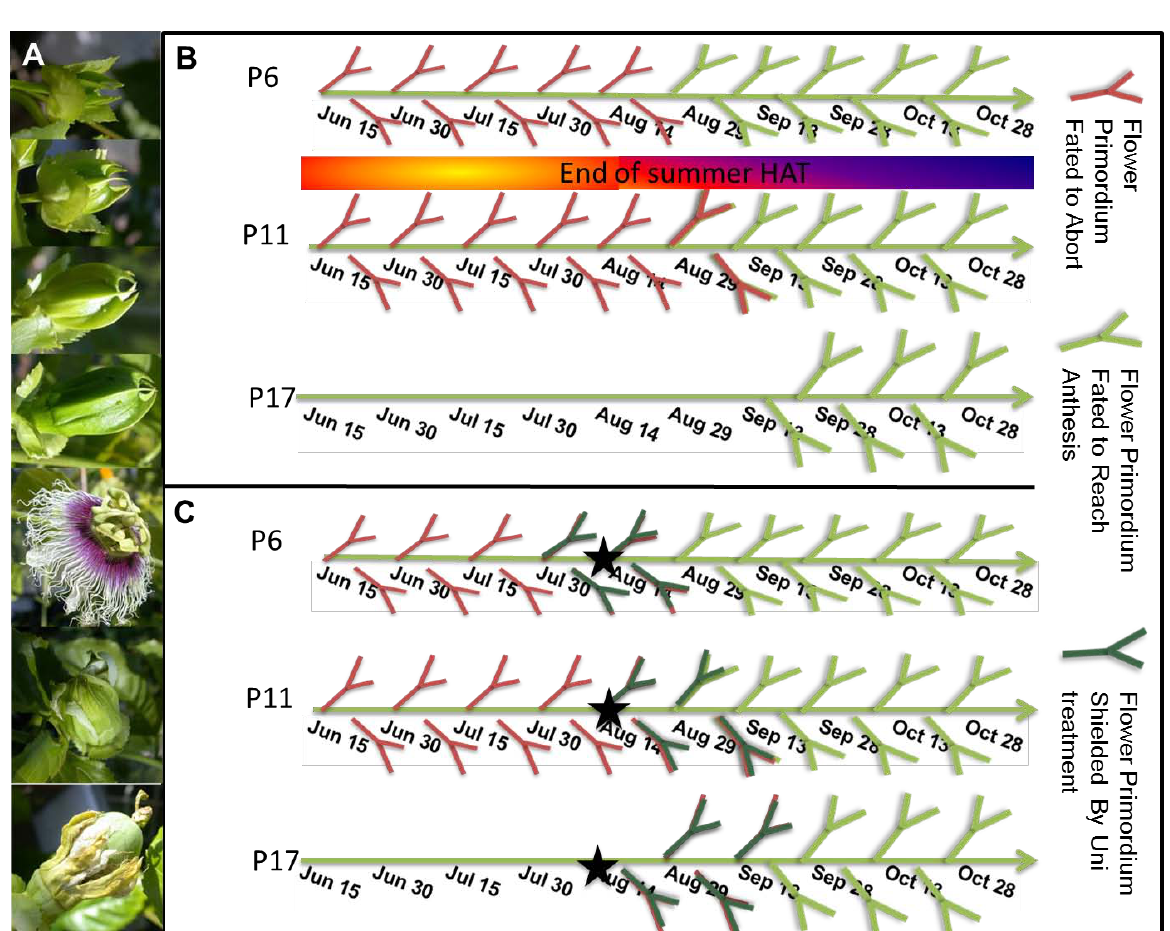
Figure 1. Mapping the fate of flower primordia. ( A ) Pictures of developing Passion dream (PD) flowers past Position Number 17 (P17) under optimal conditions, including the fruit set and the start of fruit development. For earlier stages, see [7]. Anthesis lasts around 12 h; ( B ) The fate of flower primordia during summer and fall. The upper row describes the fate of primordia that reach P6 (initiation of the flower primordium) at different dates. Primordia in red will abort before anthesis, while primordia in green will continue developing till anthesis. The first primordia that will complete development are at P6 on approximately August 28. The middle row describes the fate of primordia that reach P11 at different dates. The first primordia that will not abort (green, P6 on August 28) are at P11 on approximately September 9. The bottom row follows the fate of primordia that reach P17 on different dates. PD primordia do not reach this stage during summer. Normally, a primordium that reaches P17 intact will continue developing till anthesis, no matter the external conditions [7]; ( C ) The fate of flower primordia on vines treated with Uni on August 13 (black star). Similar to ( B ), the upper row describes the fate of primordia that reach P6 on different dates. Primordia in dark green are those saved by the treatment. Due to the treatment, the first primordia that will complete development are at P6 on approximately July 30. Not all of these primordia managed to reach anthesis. The treatment saved primordia that were not older than P11–P13 on day of transfer/treatment (DOT). The first treated primordia that reached P17 likely did so by August